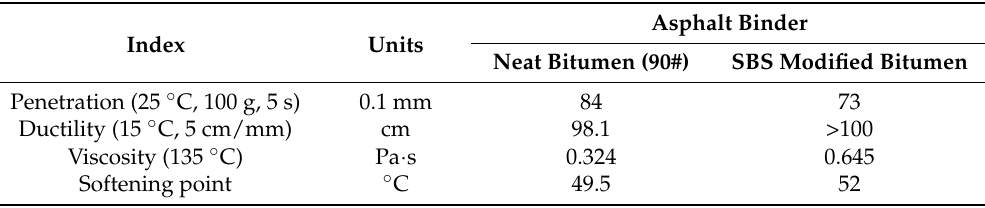
Table 1. Basic properties of the asphalt